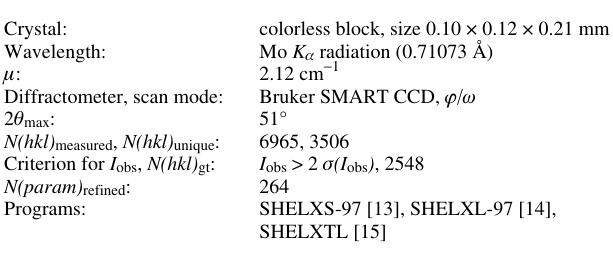
Table 1. Data collection and handling.